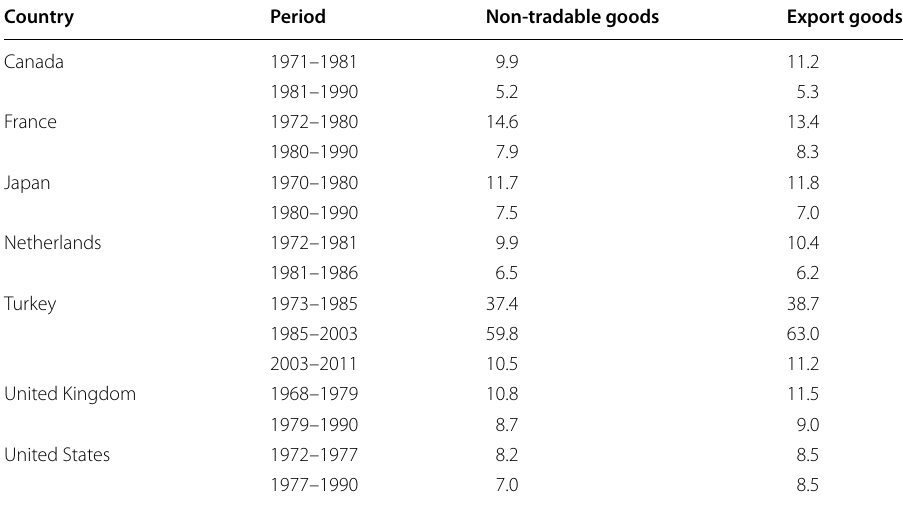
Table 9 Approximate sectoral wage growth in the countries (annual rate, unit: %). Source : Author’s calculations. For additional information see Table 1